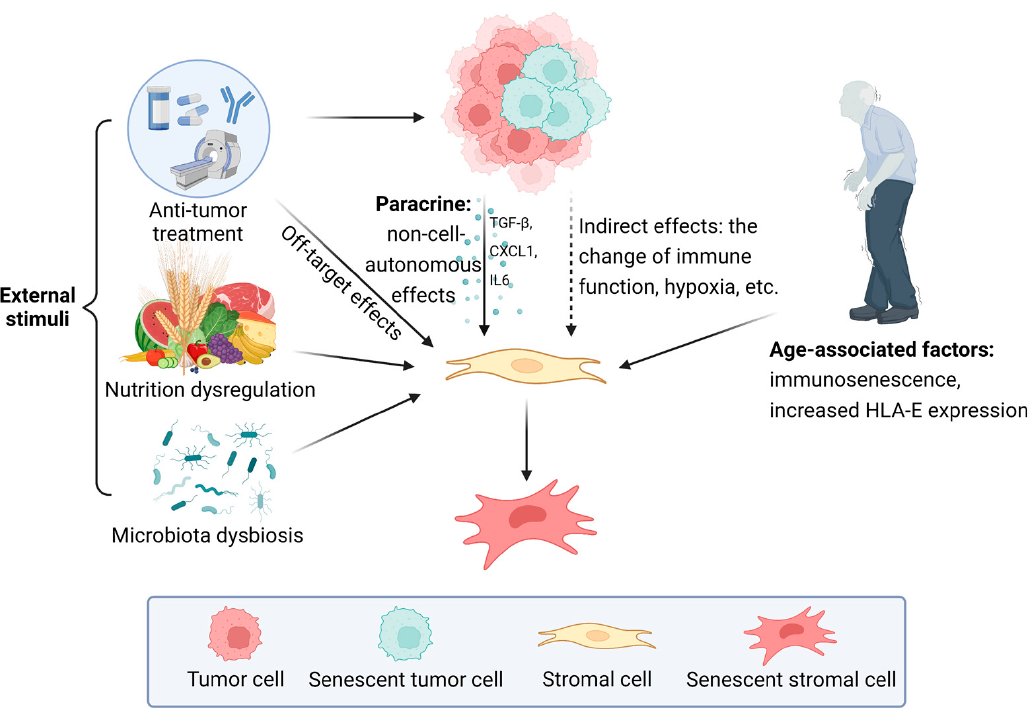
Figure 1. Mechanisms involved in the formation of senescent stroma. (Created with BioRen- der.com).